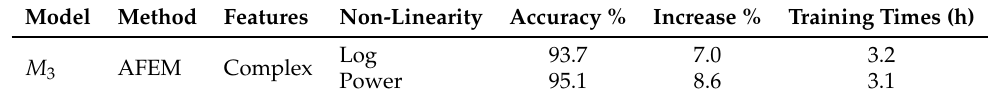
Table 8. The effec t of complex neural network. ( γ = − 1/7, Epoch = 200).